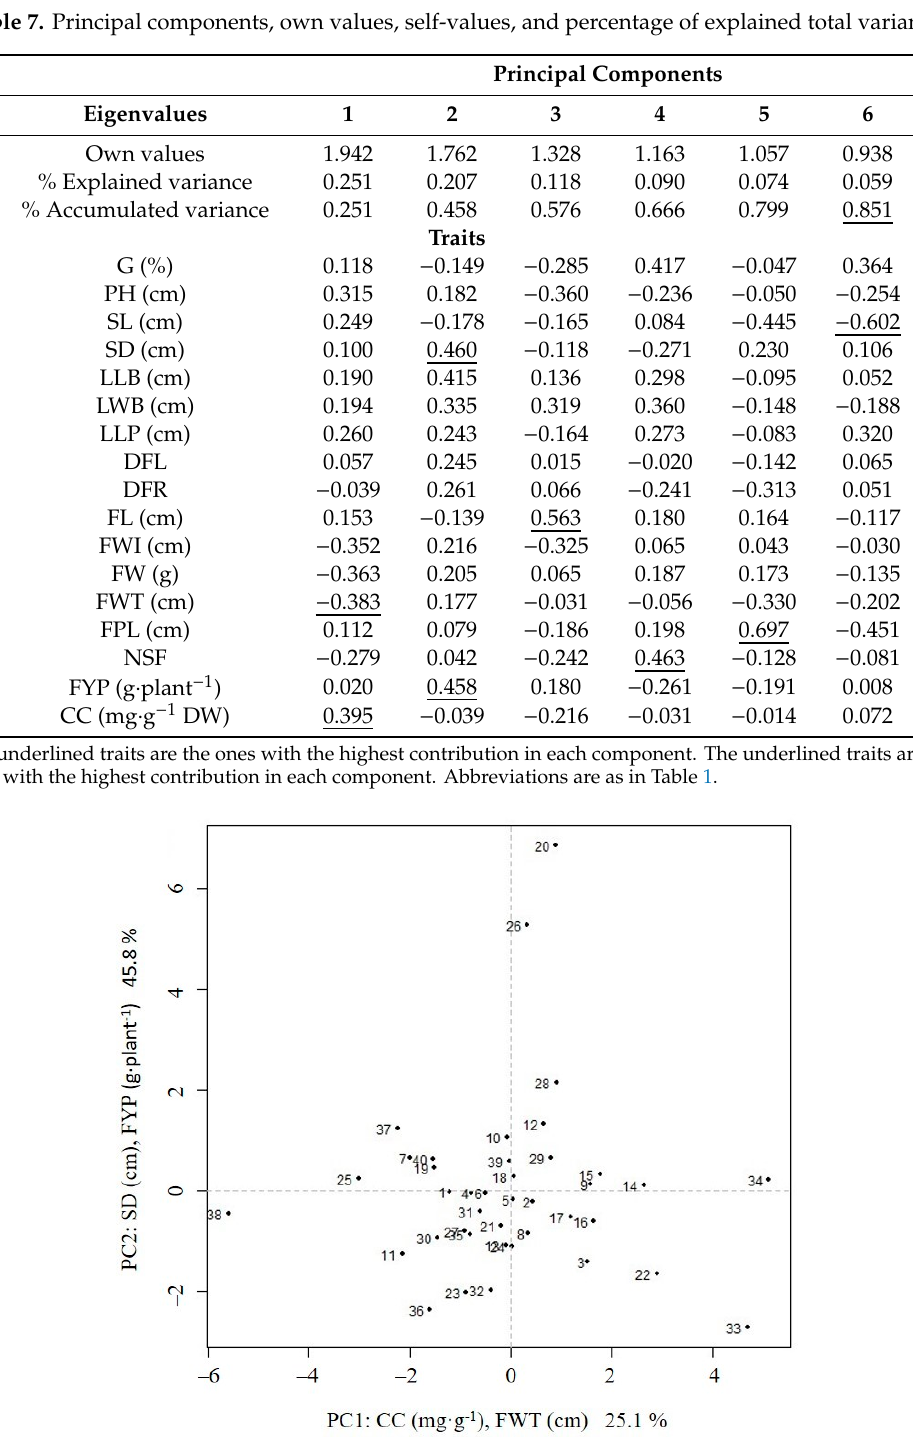
Figure 4. Dimensional representation of the distribution of F1 lines and progenitors of evaluated habanero peppers in the first two principal components. (Numbers 1–29 correspond to F1 lines H1–H29, and numbers 30–41 correspond to progenitors P30–P41).